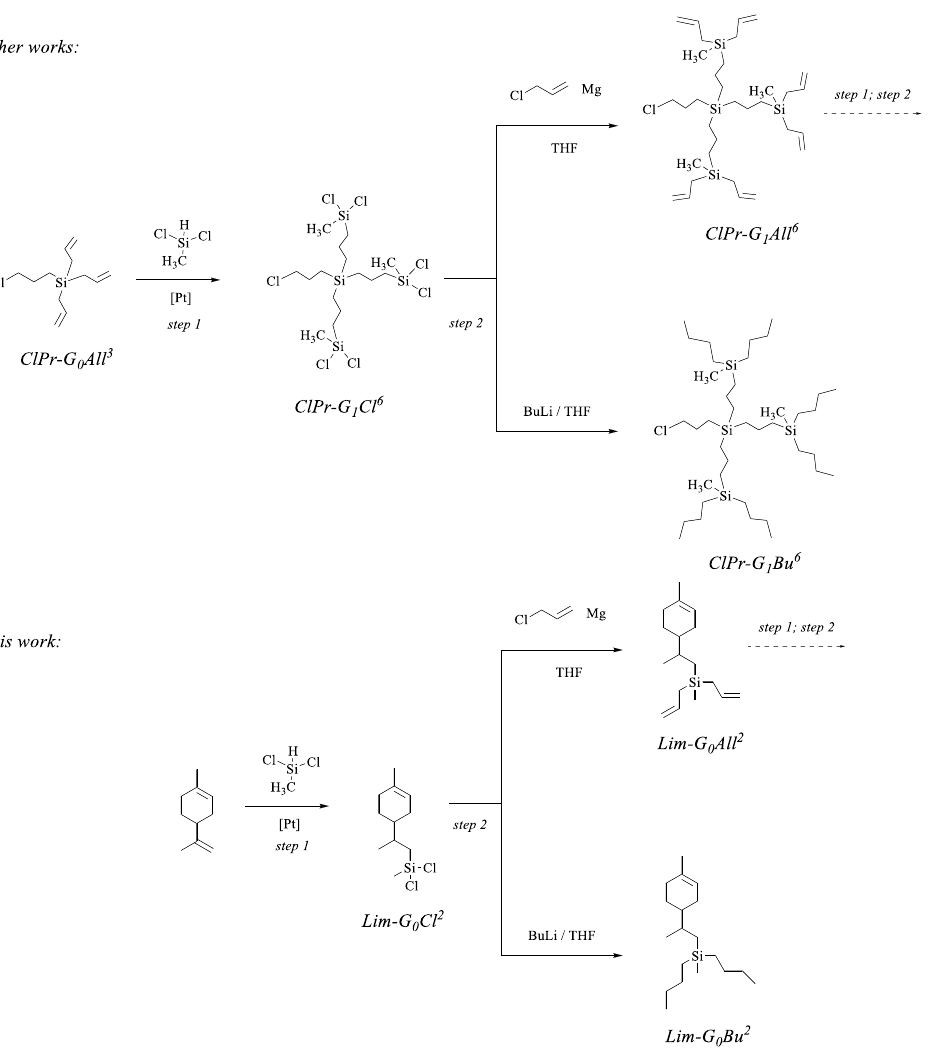
Figure 1. Typical scheme for the synthesis of carbosilane dendrons using the starting chloropropyl triallyl silane as an example ( top ); scheme for the synthesis of carbosilane dendrons based on limonene ( bottom ).